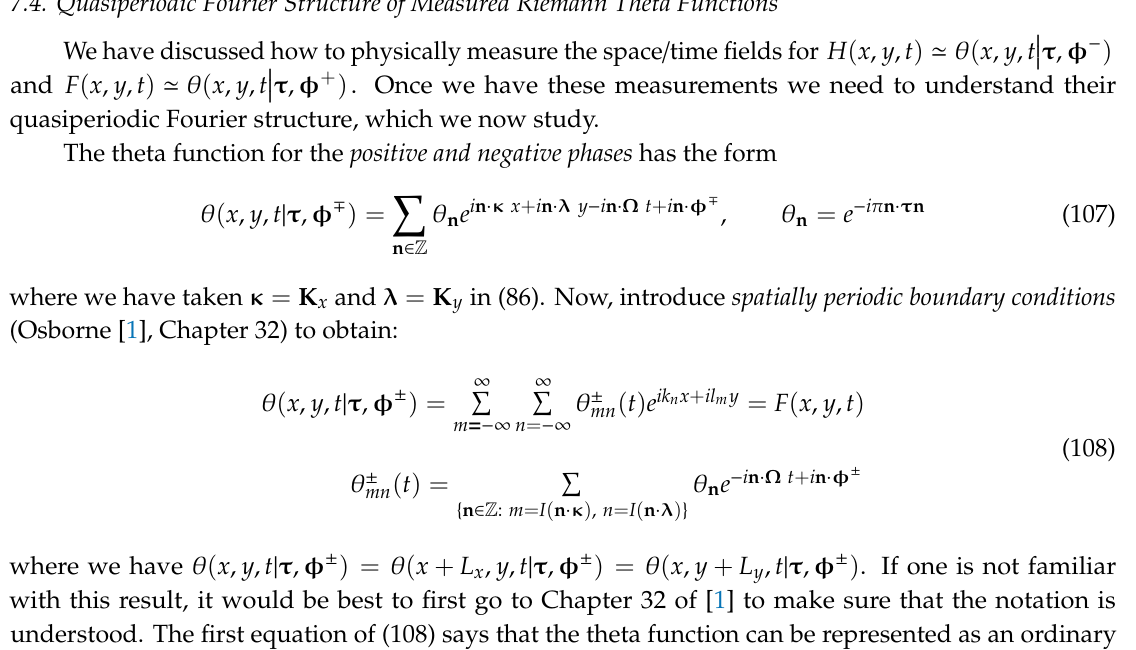
Figure 14. Determine the Riemann spectrum from measured data in one space and one-time dimensions.